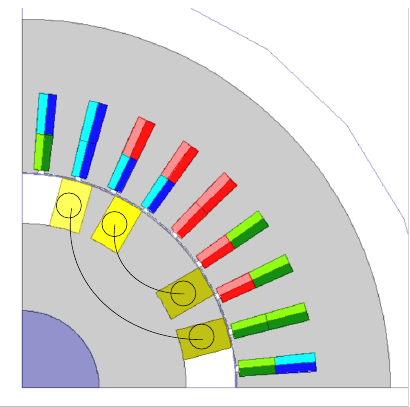
Figure 16. Design 1 (rotor radius: 74.4 mm).